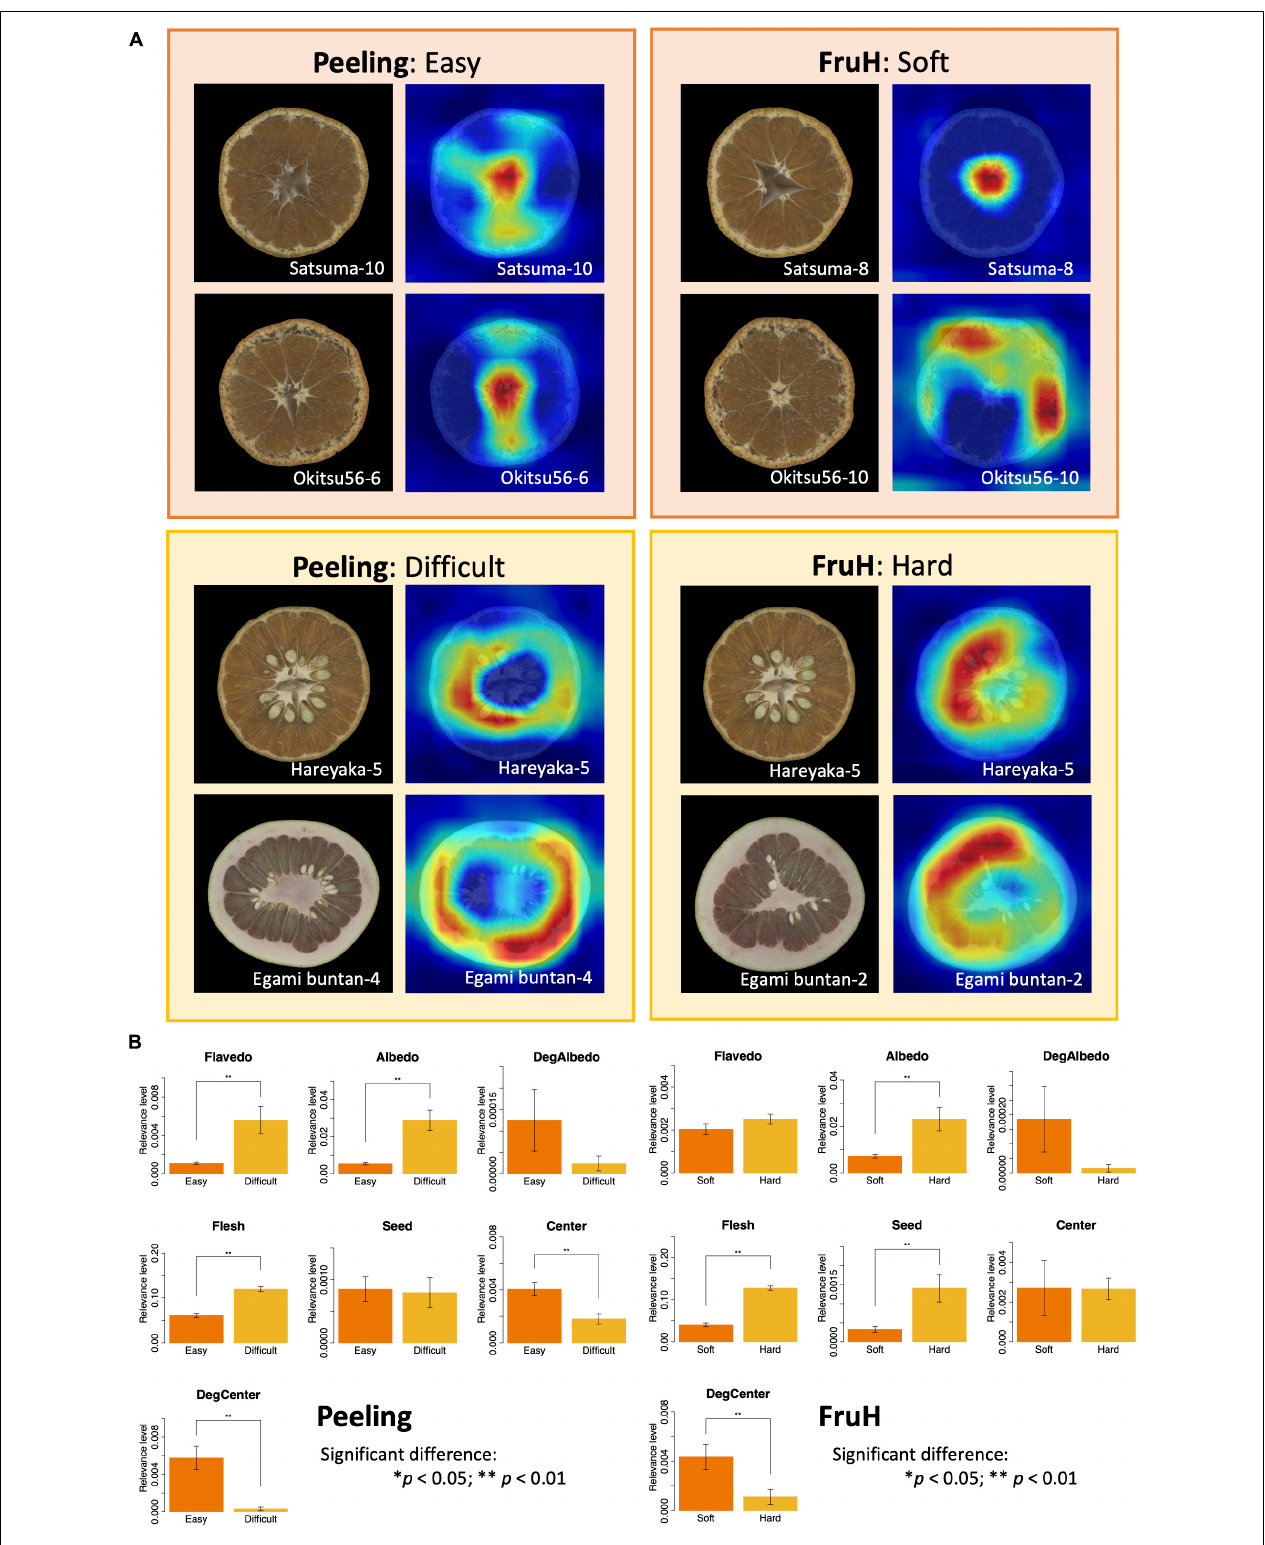
FIGURE 6 | Visualization of fruit morphological features contributing to deep learning-based classification. (A) Grad-CAM visualization using the last convolutional layer of the VGG16 model. For each trait, the left and right images indicate the original and feature-visualized images, respectively. (B) Differences in the relevance levels between the classification classes for each fruit morphological region. Asterisks indicate statistically significant differences: * p < 0.05; ** p < 0.01.